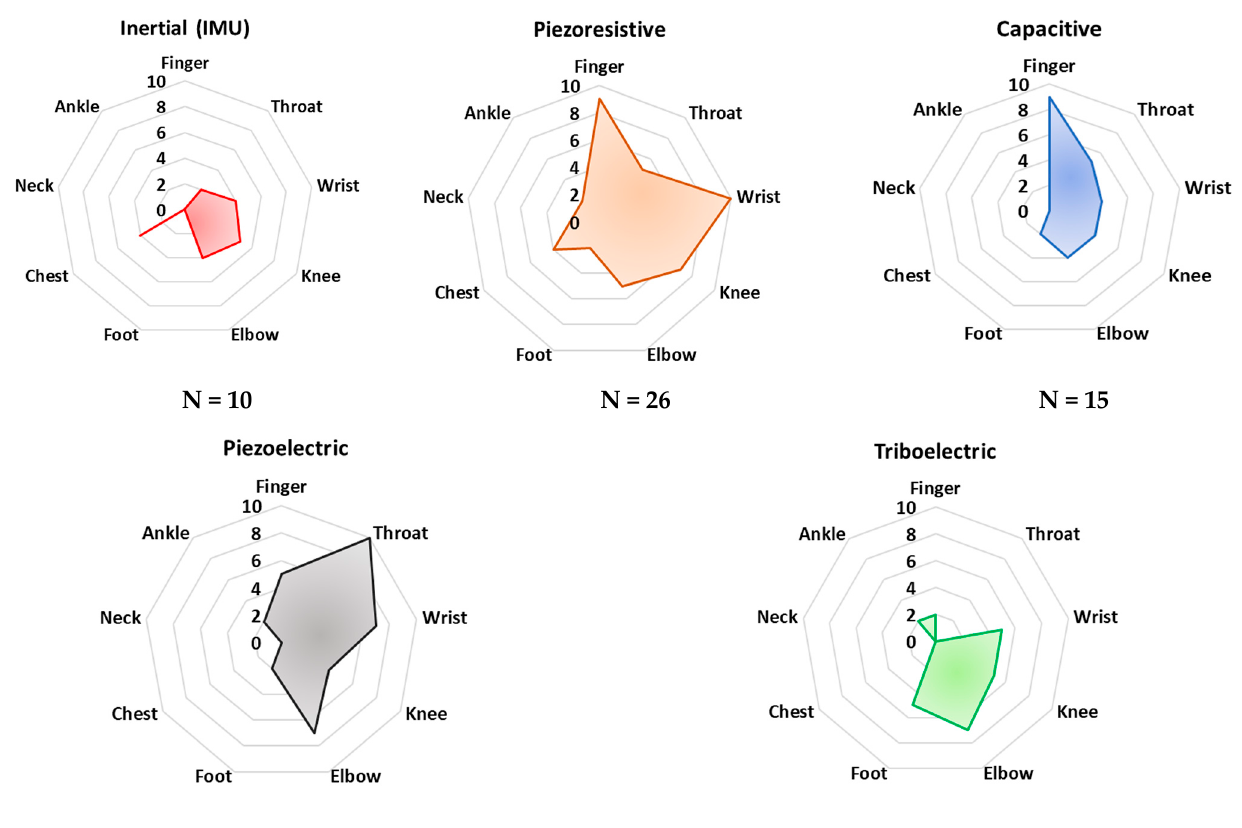
Figure 7. Radar charts for comparison of the main transduction mechanisms to monitor human bio–physical parameters according to the area of sensor application on the body. The scale (0–10) indicates the “frequency” with which a specific sensing technology is applied for monitoring a given body area. Additionally, the analyzed population (N) is reported for each sensing technology.